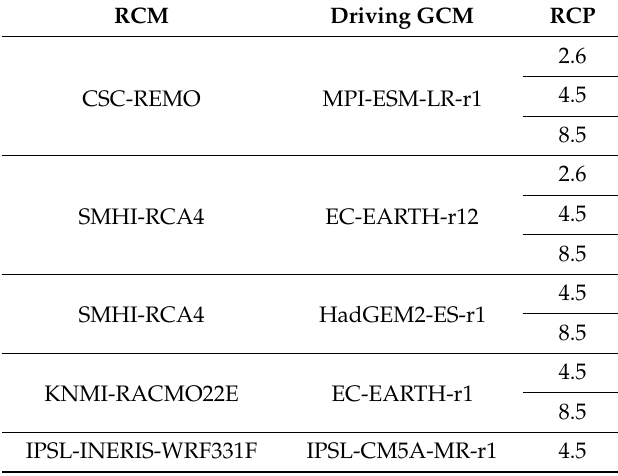
Table 1. The 11 climate projections used in this